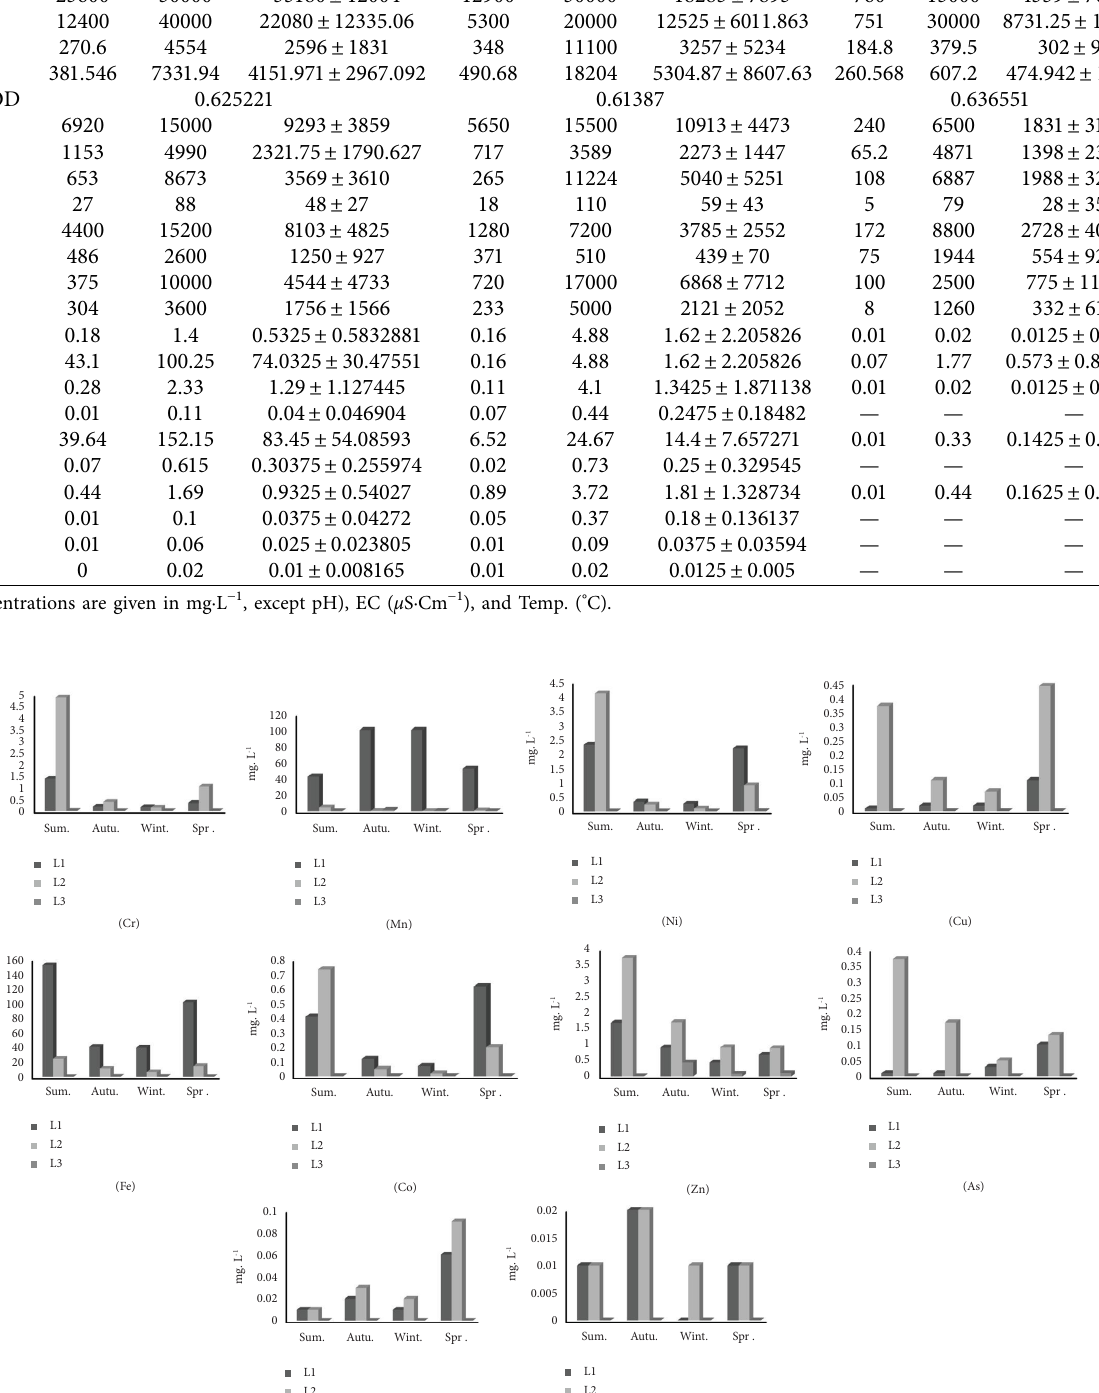
SO 42 − 8673 3569 ± 3610 11224 Mg 2600